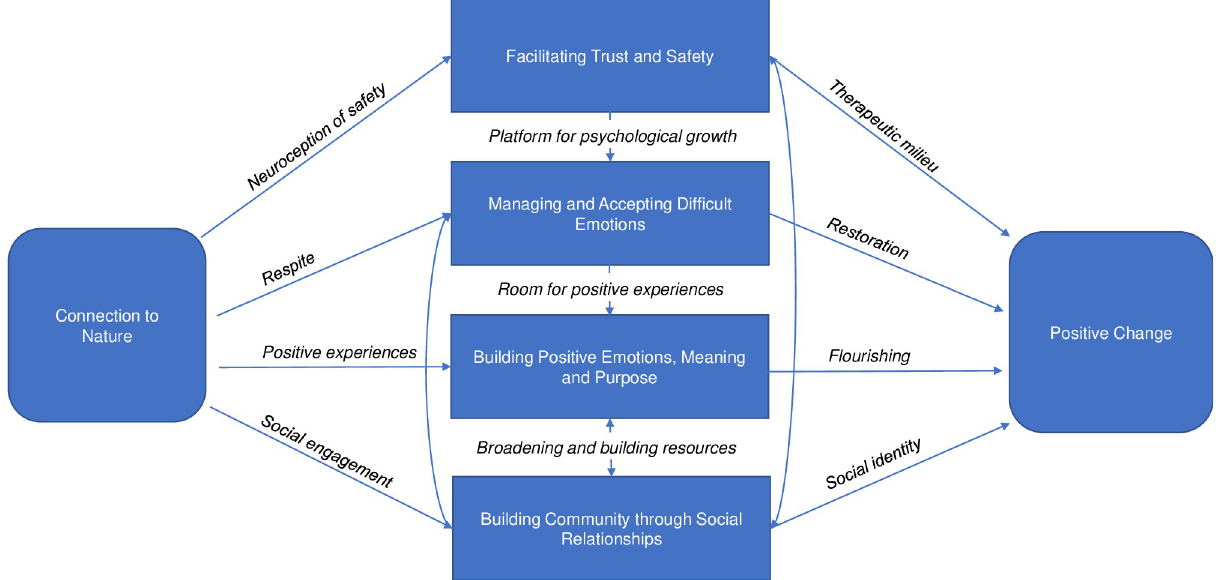
Fig 1. A proposed conceptual model for the benefits of surf therapy in people living with acquired brain injury, illustrating potential relationships between overarching themes and potential underlying mechanisms. Figure from Kemp & Fisher (2022) (CC BY 4.0).